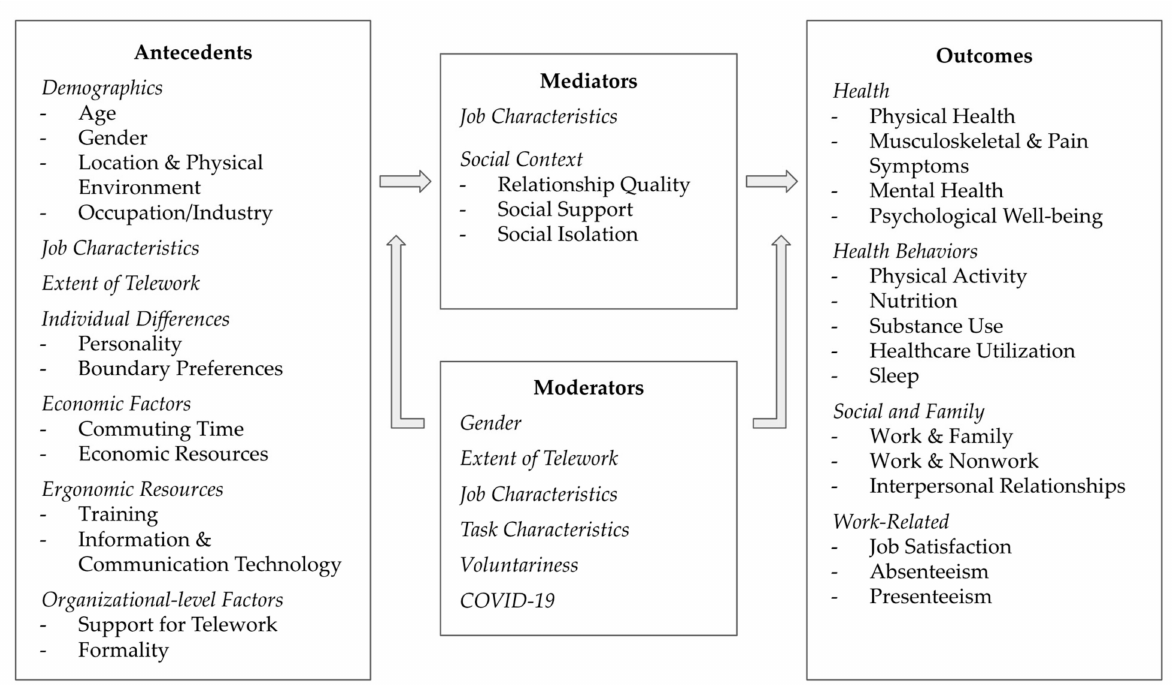
Figure 1. Conceptual model of telework and worker health and